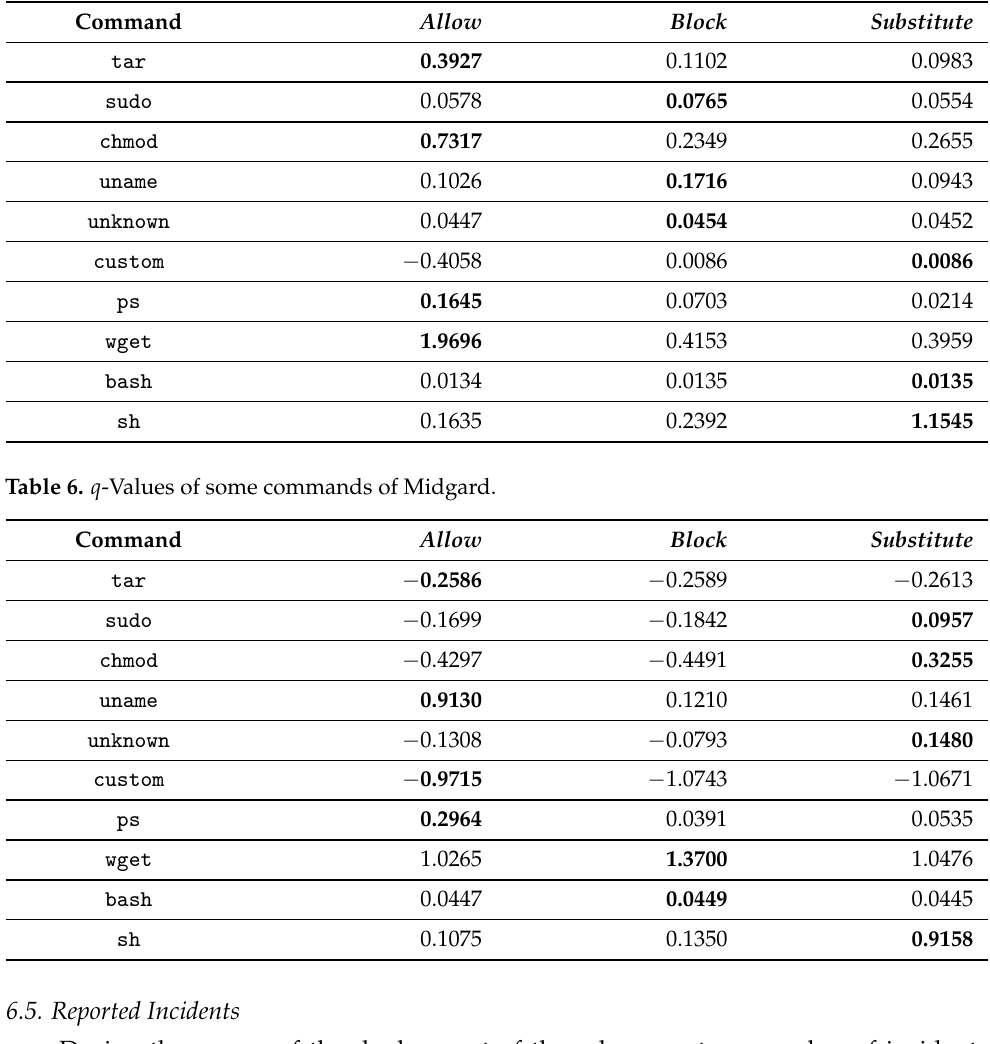
Table 5. q -Values of some commands of Asgard.